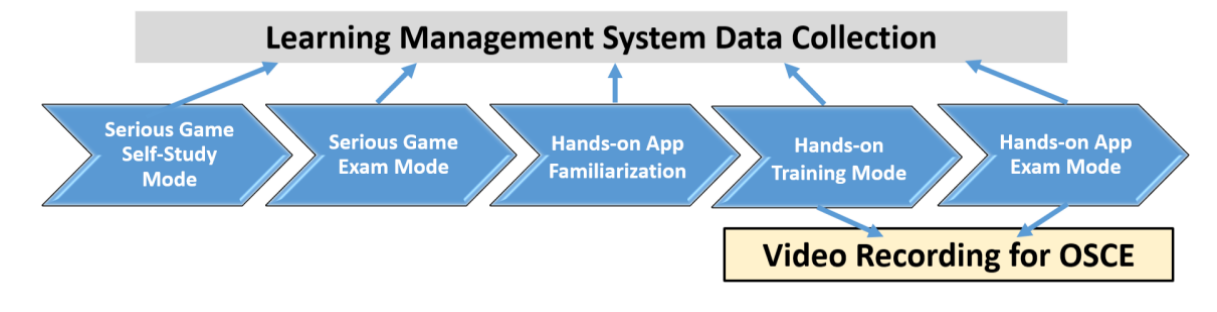
Figure 1. Design of the study flow.